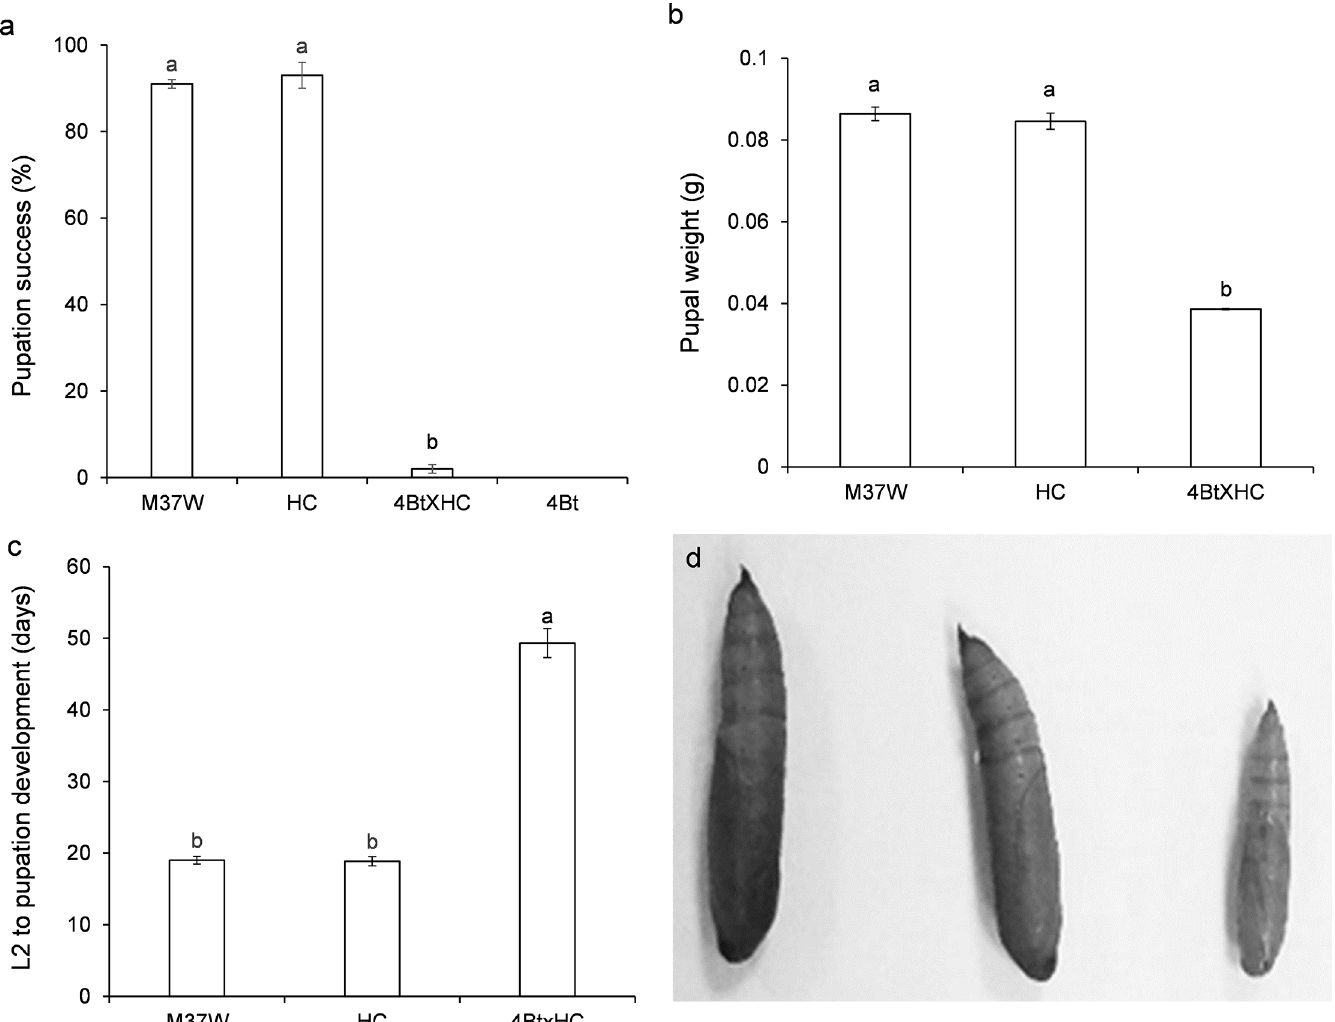
Fig 4. Non-lethal effects (mean ± S.E.) on Ostrinianubilalis larvae fed from second instar to pupation on a diet made with kernels of different maize lines. 4Bt contained the Cry1Ac toxin, HC was the transformed line with high carotenoid content, M37W was the near isogenic line, and 4BtxHC was the line with the two traits. a) Percentage of pupation [F = 541.27; P < 0.001; df = 3,156]. b) pupal weight [F = 34.04; P < 0.001; df = 2,56]. (g) c) Larval development from bioassay initiation to pupation [F = 98.16; P < 0.001; df = 2,56]. and d) Pupal size of O . nubilalis larvae fed for four weeks on a diet made with grains of M37W (control, left figure), HC (middle), and 4BtxHC (right figure) plants. Different letters indicate statistically significant differences between the lines (P < 0.001) when data were analysed by one- way (plant line) ANOVA.